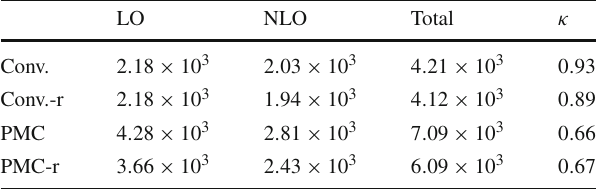
Table 2 The LO and NLO terms of R under the mMOM-scheme, respectively LO NLO Total κ Conv.